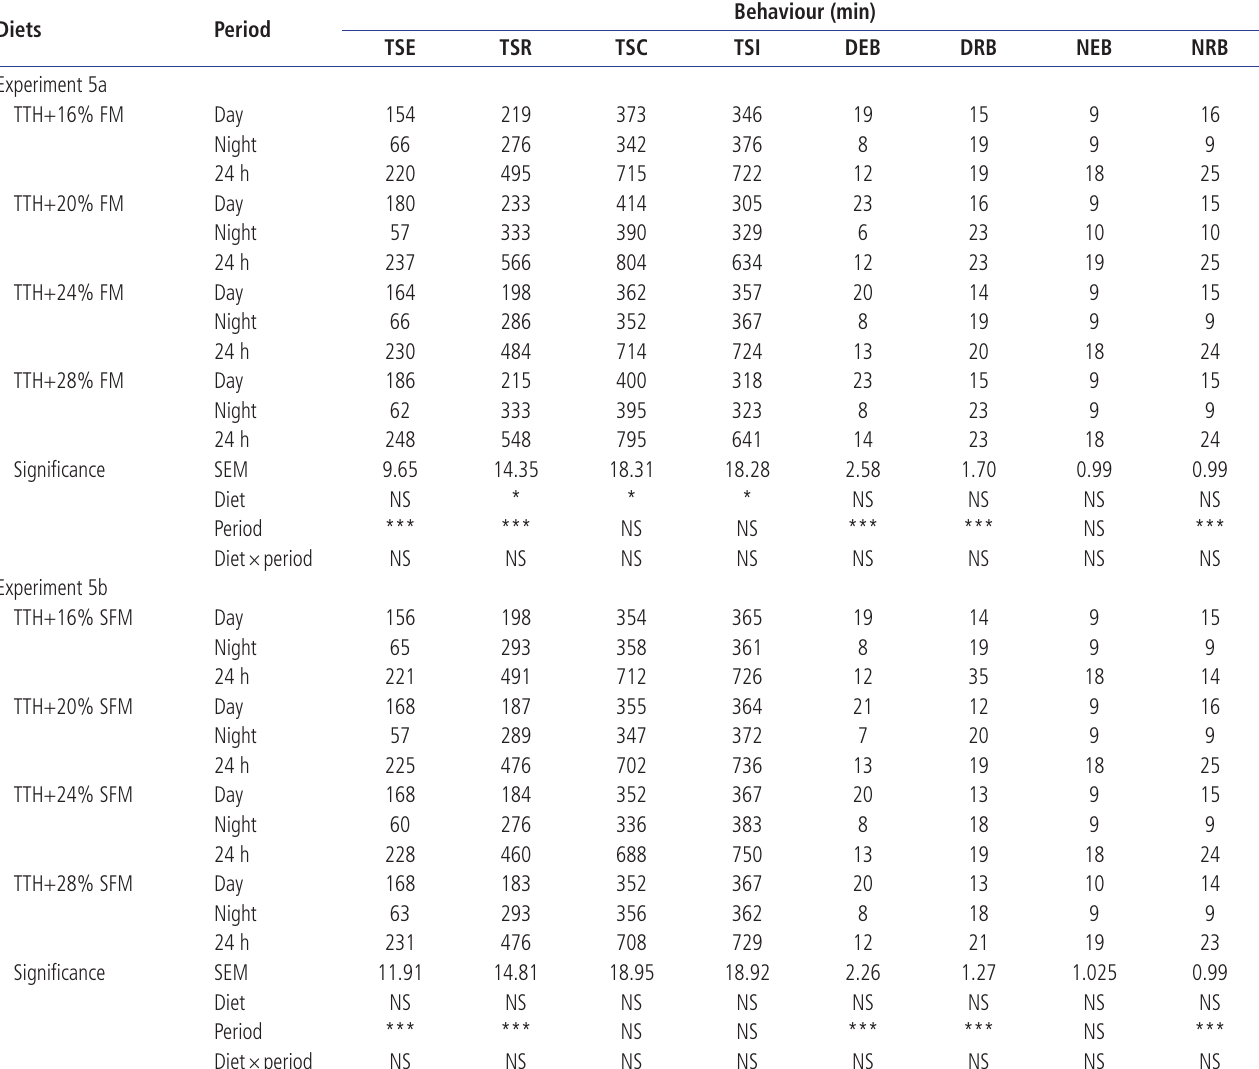
Table 8. Effect of different inclusion levels of fish meal and sunflower meal on duration of day-time and night-time feeding behaviour patterns in Merino sheep (Exp 5) Diets